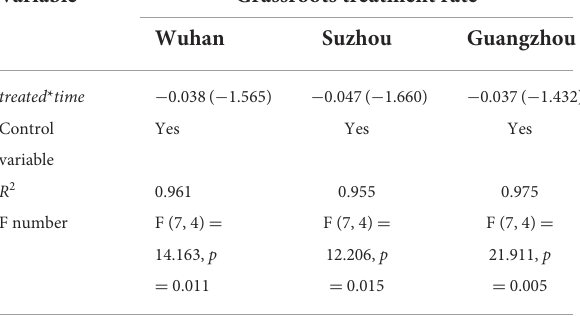
TABLE 2 Results of placebo test.